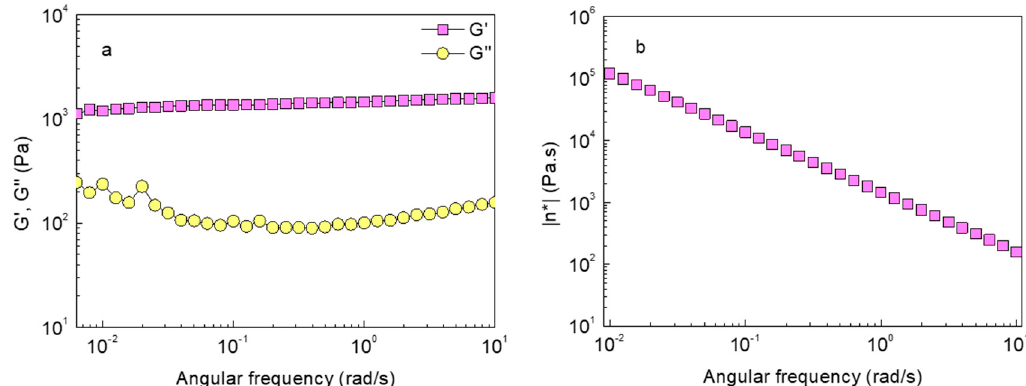
Figure 1. Angular frequency dependence of ( a ) storage (G’) and loss (G”) modulus and ( b ) complex viscosity | η *|, of PAA-g-P(b-LL) aqueous solution of, C p = 1 wt%, at pH 8.8.